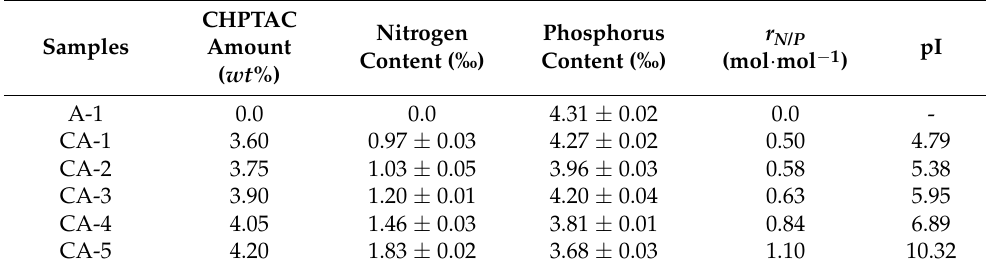
Table 2. Effects of CHPTAC amount on the content of nitrogen and phosphorus, r N/P , and pI of